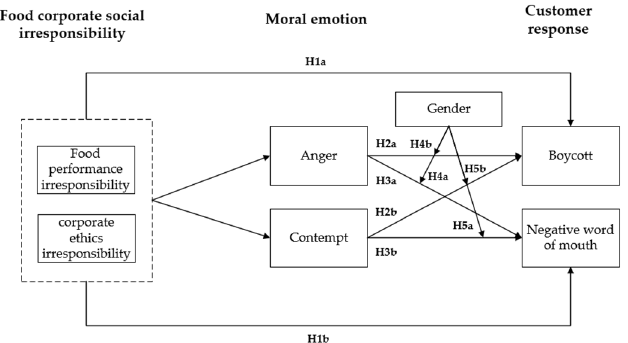
Figure 1. Theoretical model of consumer response to food corporate social irresponsibility.